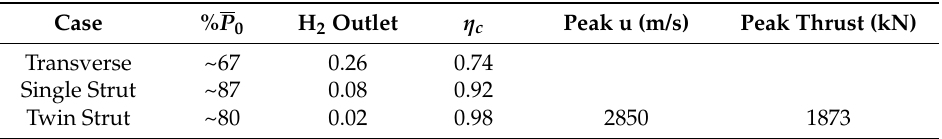
Table 7. 2-D scramjet performance data for varied injector configurations.